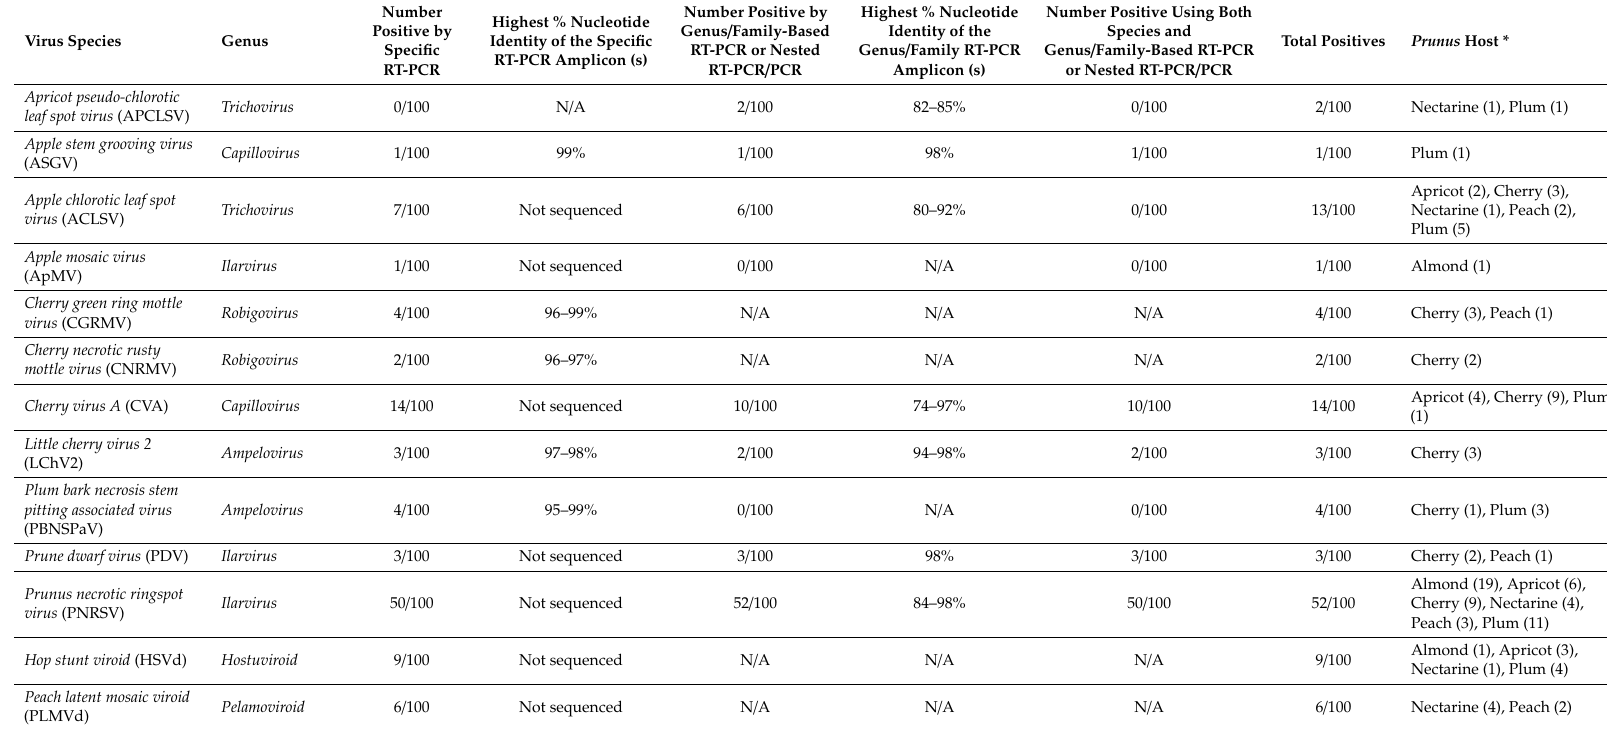
Table 2. The virus and viroid species that were detected by specific and / or genus / family-based RT-PCR or nested RT-PCR / PCR in Australian Prunus trees, the frequency of detection by both tests, the highest percentage (%) BLAST nucleotide identity of sequenced amplicons from both tests and the hosts in which they were detected are